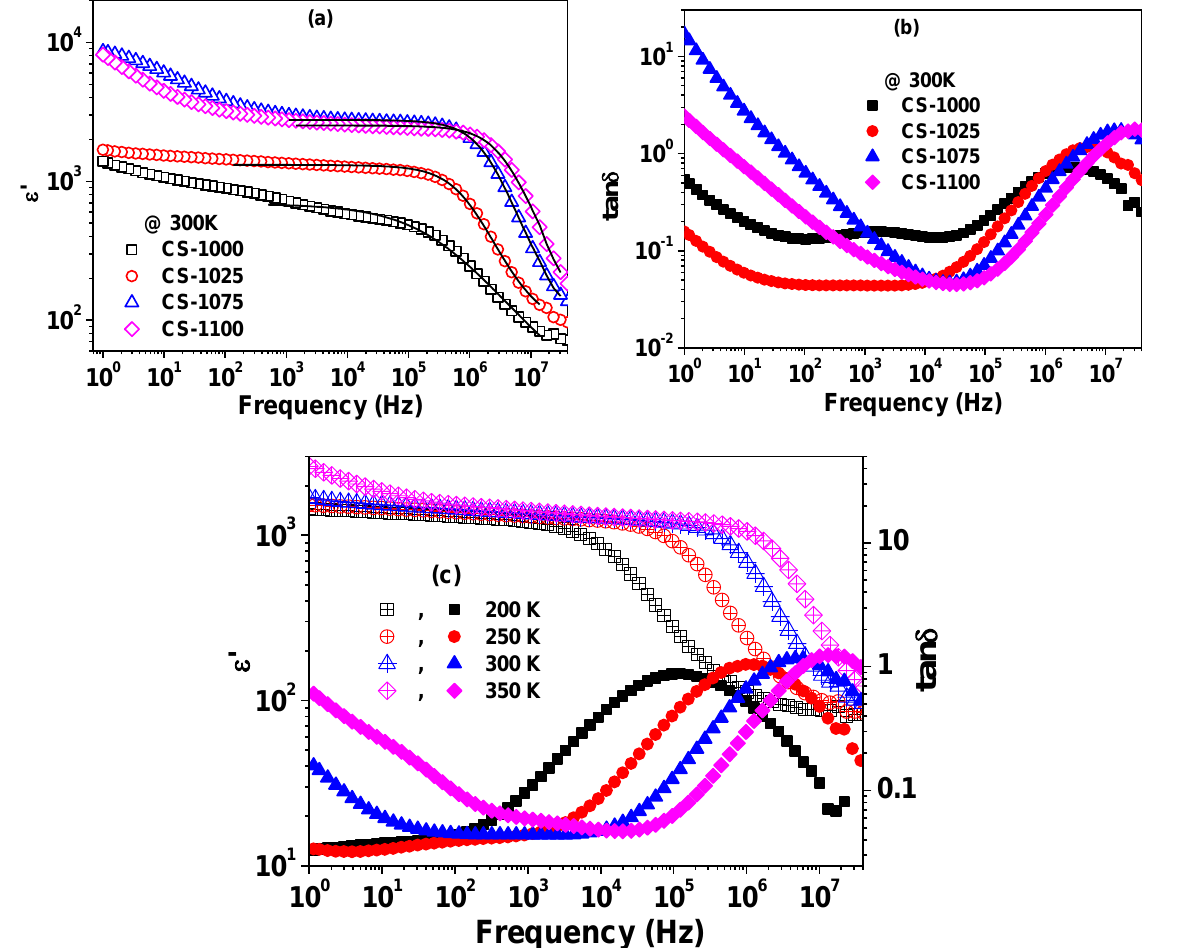
Figure 5. Frequency dependence of ( a ) ε ′, ( b ) tanδ at 300 K for NSCTO ceramics, and ( c ) the frequency dependence of ε ′ and tanδ at selected temperatures for CS-1025.